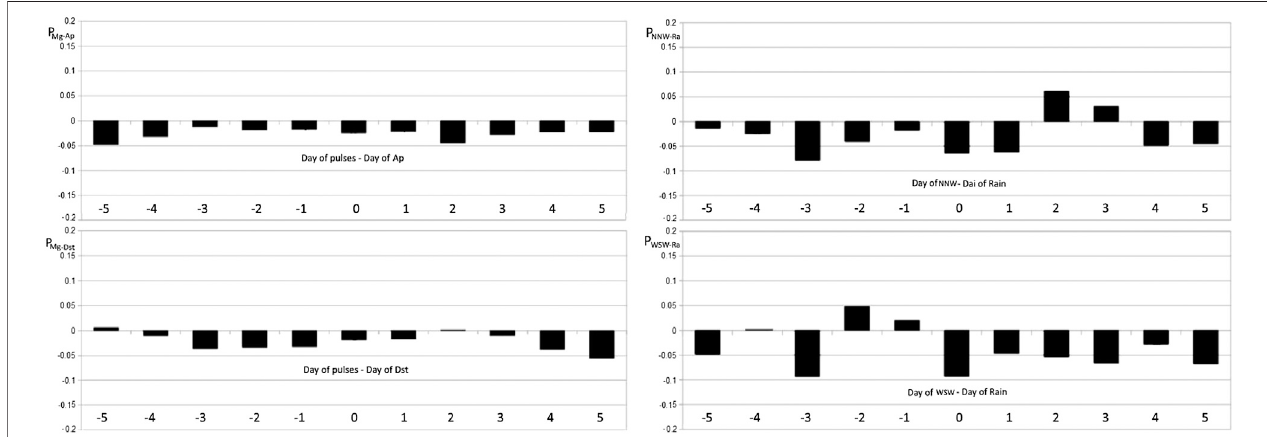
FIGURE10| Statisticalcorrelationsof ± 5 daysintimedifferencesbetweenmagneticpulsesandApindextimeseries,andbetweenmagneticpulsesandDstindex timeseriesontheleft,degreeoffreedomwere835;betweenNNWelectricaloscillationsandrainatChietiScalotimeseries,andbetweenWSWelectricaloscillationsand rain at Chieti Scalo time series on the right, degree of freedom were